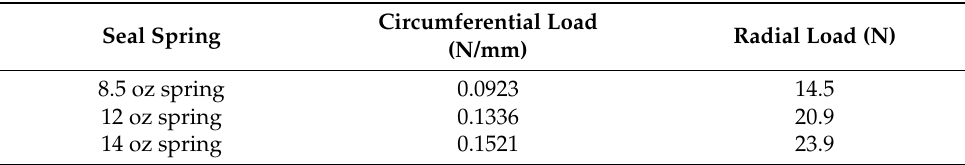
Table 5. Radial and Circumferential seal loads for varying seal spring.